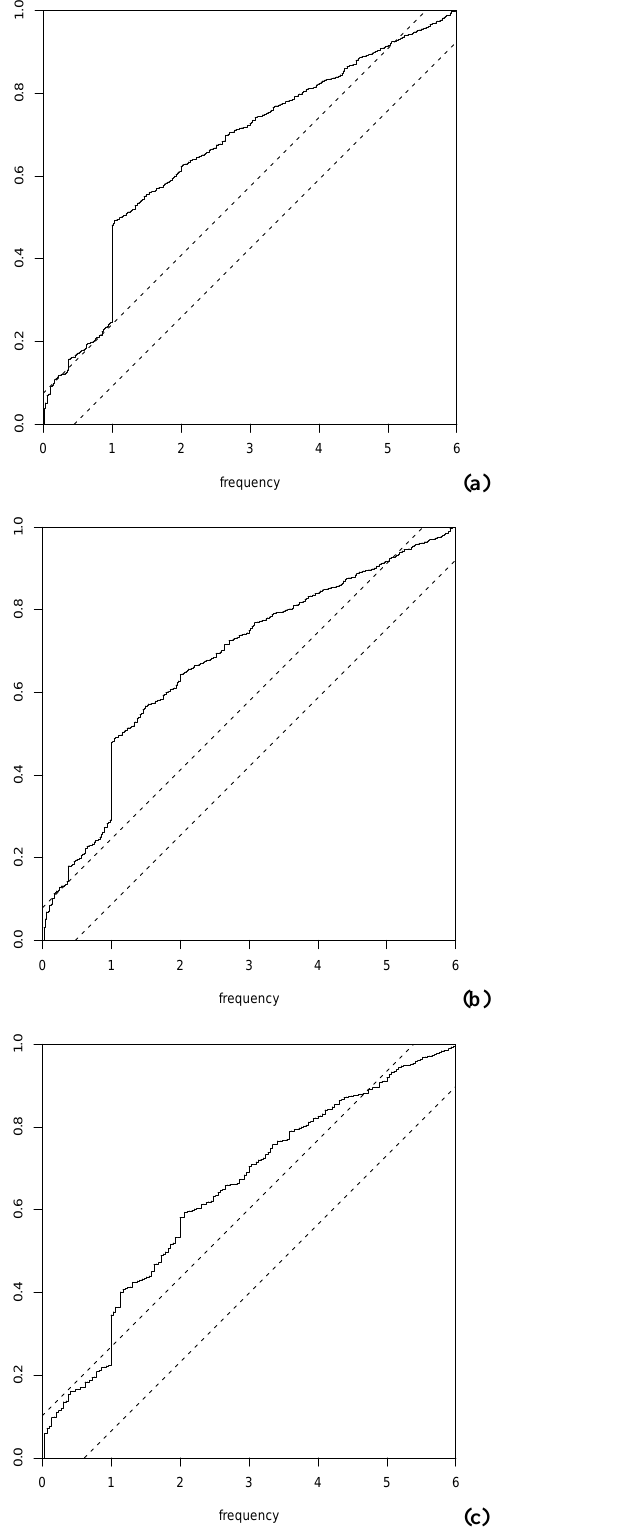
Fig. 3. Regression models: MSL versus SLP (a) Newlyn, (b) Brest and (c)